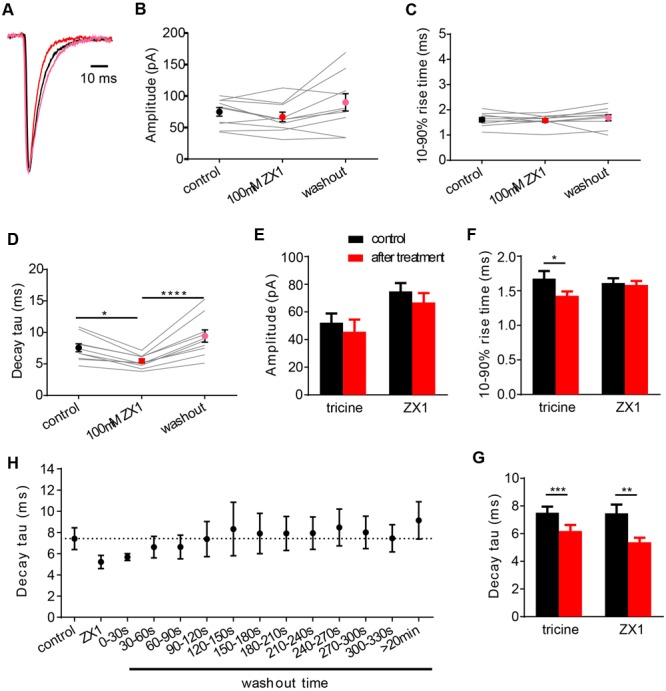
Effects of 100 μM ZX1 on IPSCs mediated by α1β GlyRs. (A) Superimposed averaged, normalized IPSCs each averaged from >50 events from the same cell. Recordings were made in the presence of control solution (black trace; averaged from 79 events), after addition of 100 μM ZX1 (red trace; averaged from 61 events) and after 5 min washout (pink trace; averaged from 52 events). (B–D) Effects of 100 μM ZX1 on IPSC amplitude, decay time constant and 10–90% rise time for α1β-mediated IPSCs. All results were averaged from 10 cells. Statistical significance in (D) was determined by Friedman test with significance represented by ∗p < 0.05, and ∗∗∗∗p < 0.0001. (E–G) Comparison of the effects of 10 mM tricine and 100 μM ZX1 on IPSC amplitude, decay time constant and 10–90% rise time for α1β-mediated IPSCs. There was no significant difference in the decay time constants in either condition. Statistical significance in (G) was determined by two-tailed Wilcoxon matched-pairs signed rank test, with significance represented by ∗∗p < 0.01 and ∗∗∗p < 0.001. (H) Time course of washout of the ZX1 effect on decay time constant. ZX1 was applied for 3 min. All data points were averaged from five cells.